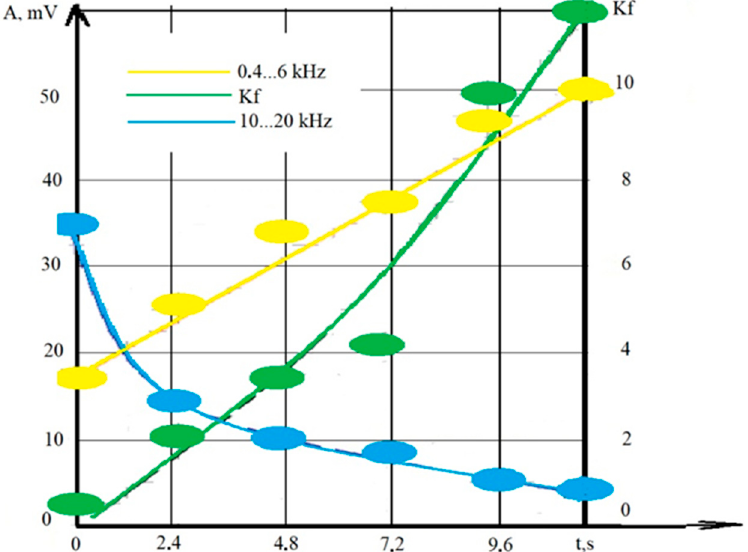
Figure 20. The change in the effective amplitude of the VA signal in the frequency bands of 0.4–6 kHz, 10–20 kHz, and their ratio K f over time due to contamination of the interelectrode gap by erosion products during cutting of Al 2 O 3 -30% TiC ceramics.